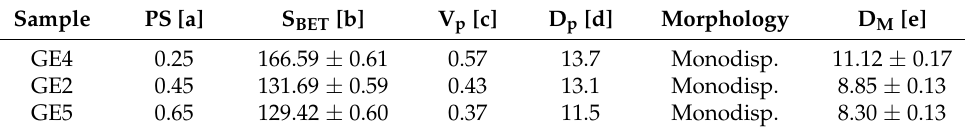
Table 2. Effect of PS seed amount on morphology and porous